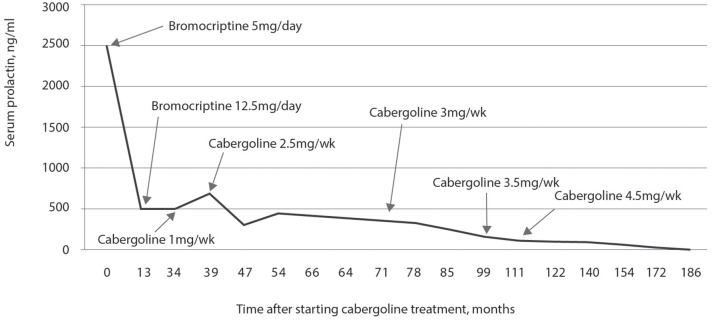
Plasma prolactin concentrations during 15 years of treatment with dopaminergic agonists. During the first 34 months there was a significant reduction with the use of bromocriptine (final dose of 12.5 mg per day). In the 34th month, treatment with 2 mg per week of cabergoline was started and there was a significant reduction in prolactin after only 20 months of treatment with 2.5 mg per week of cabergoline. The reduction was most significant when the dose of cabergoline was increased to 4.5 mg per week after 111 months of treatment with dopaminergic agonists.